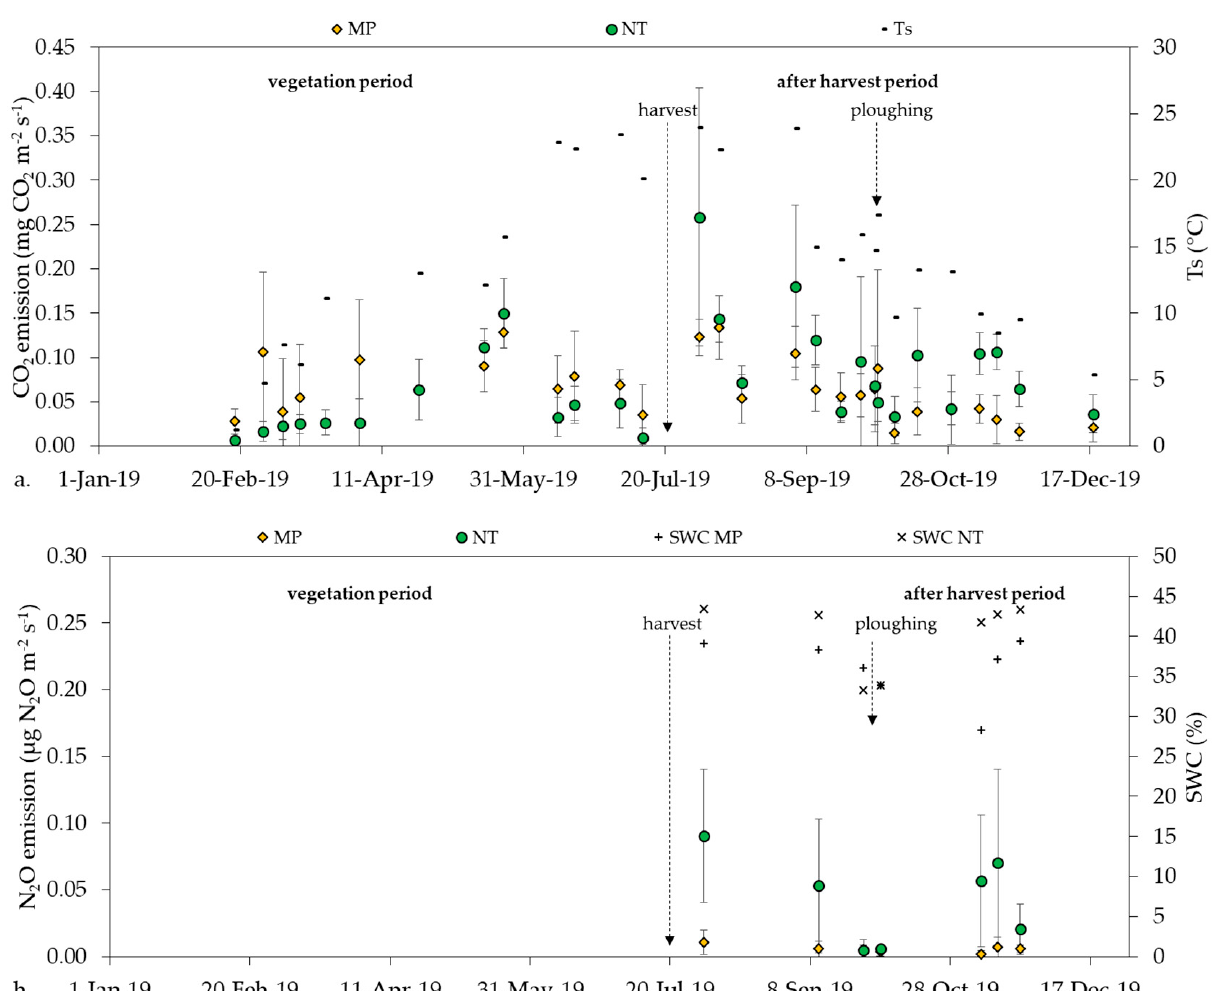
Figure 3. ( a ) The annual course of CO 2 emission with soil temperature (Ts) and ( b ) half-year course of N 2 O with soil water content (SWC). Table 10. Mean values of GHG emissions divided into different periods. Small letters indicate significant differences between the different periods within a treatment. Tillage treatments: MP: mouldboard ploughing, NT: no-tillage. (Sample numbers are presented in Table 4). Treatment vegetation period after-harvest